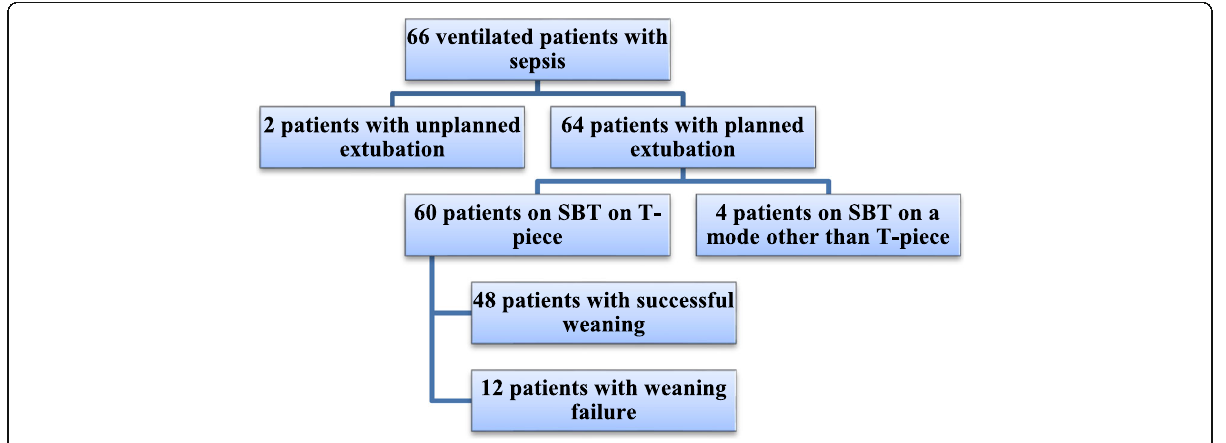
Fig. 3 Showing flow chart for selection of the patient. SBT spontaneous breath